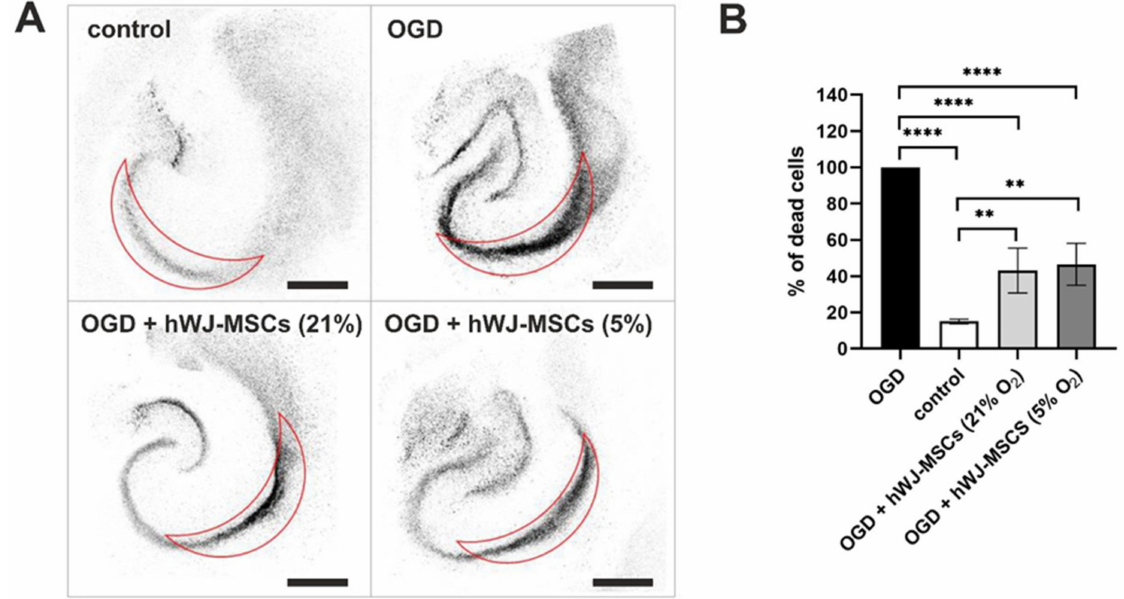
Figure 8. Neuroprotective effect of hWJ-MSCs cultured under 21% and 5% O 2 . ( A ) Confocal images of hippocampal slices for 4 investigated groups: control (without OGD), after OGD, after OGD and coculture with hWJ-MSCs from 21% O 2 , after OGD and coculture with hWJ-MSCs from 5% O 2 (scale bars: 500 µ m). The results for cells isolated from WJ-MSC (3) donor are presented as representative. ( B ) Quantitative evaluation of neuronal death in the CA1 region. The results are expressed as the mean ± SD of 4 investigated donors at 4 replications ( n = 16). The asterisks denote significant differences (** p < 0.001, **** p < 0.00001) between the investigated